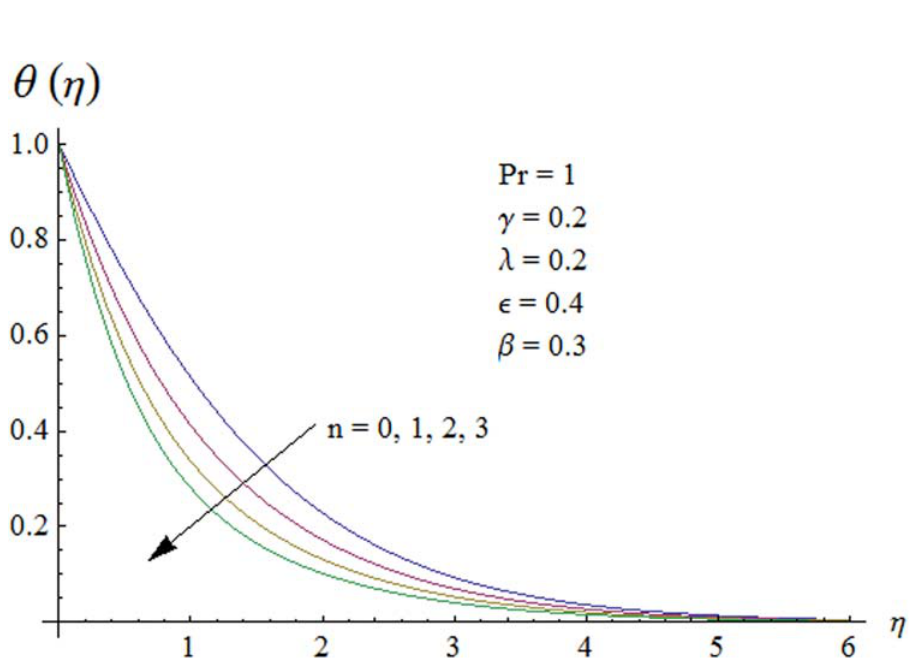
Fig 15. Effect of n on temperature profile.